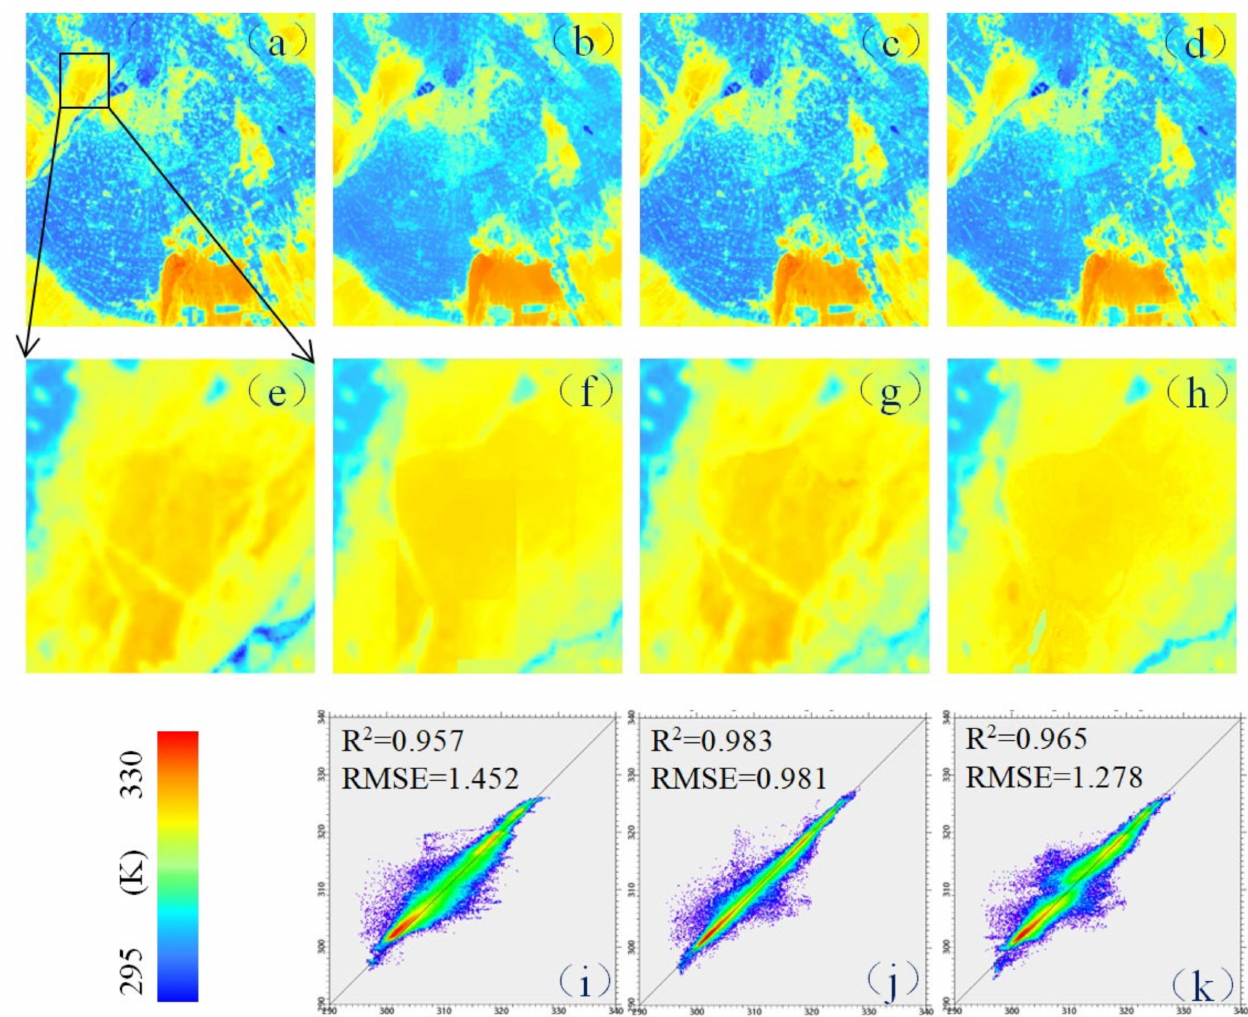
Figure 9. Results of fusing simulated MODIS LST and Landsat 8 LST on 9 August 2014. ( a ): Actual Landsat 8 LST; ( b ): STARFM LST; ( c ): ESTARFM LST; ( d ): FSDAF LST; ( e – h ): the subsets of ( a – d ) corresponding to the black square area in ( a ). ( i – k ): scatter plot between ( a ) and ( b – d